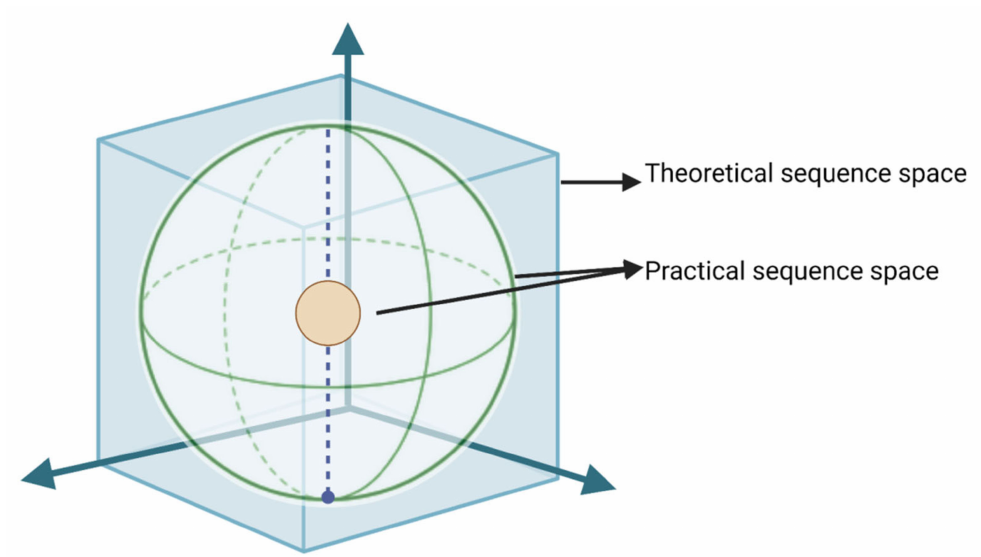
Figure 3. This is a simplified model of a 3D representation of the theoretical sequence space possible and available sequence space for viruses. Here, the square depicts the theoretical sequence space. The sphere represents the occupancy of virus mutants. This 10-fold difference in the smaller and bigger sphere explains the difference in the available occupancy of two